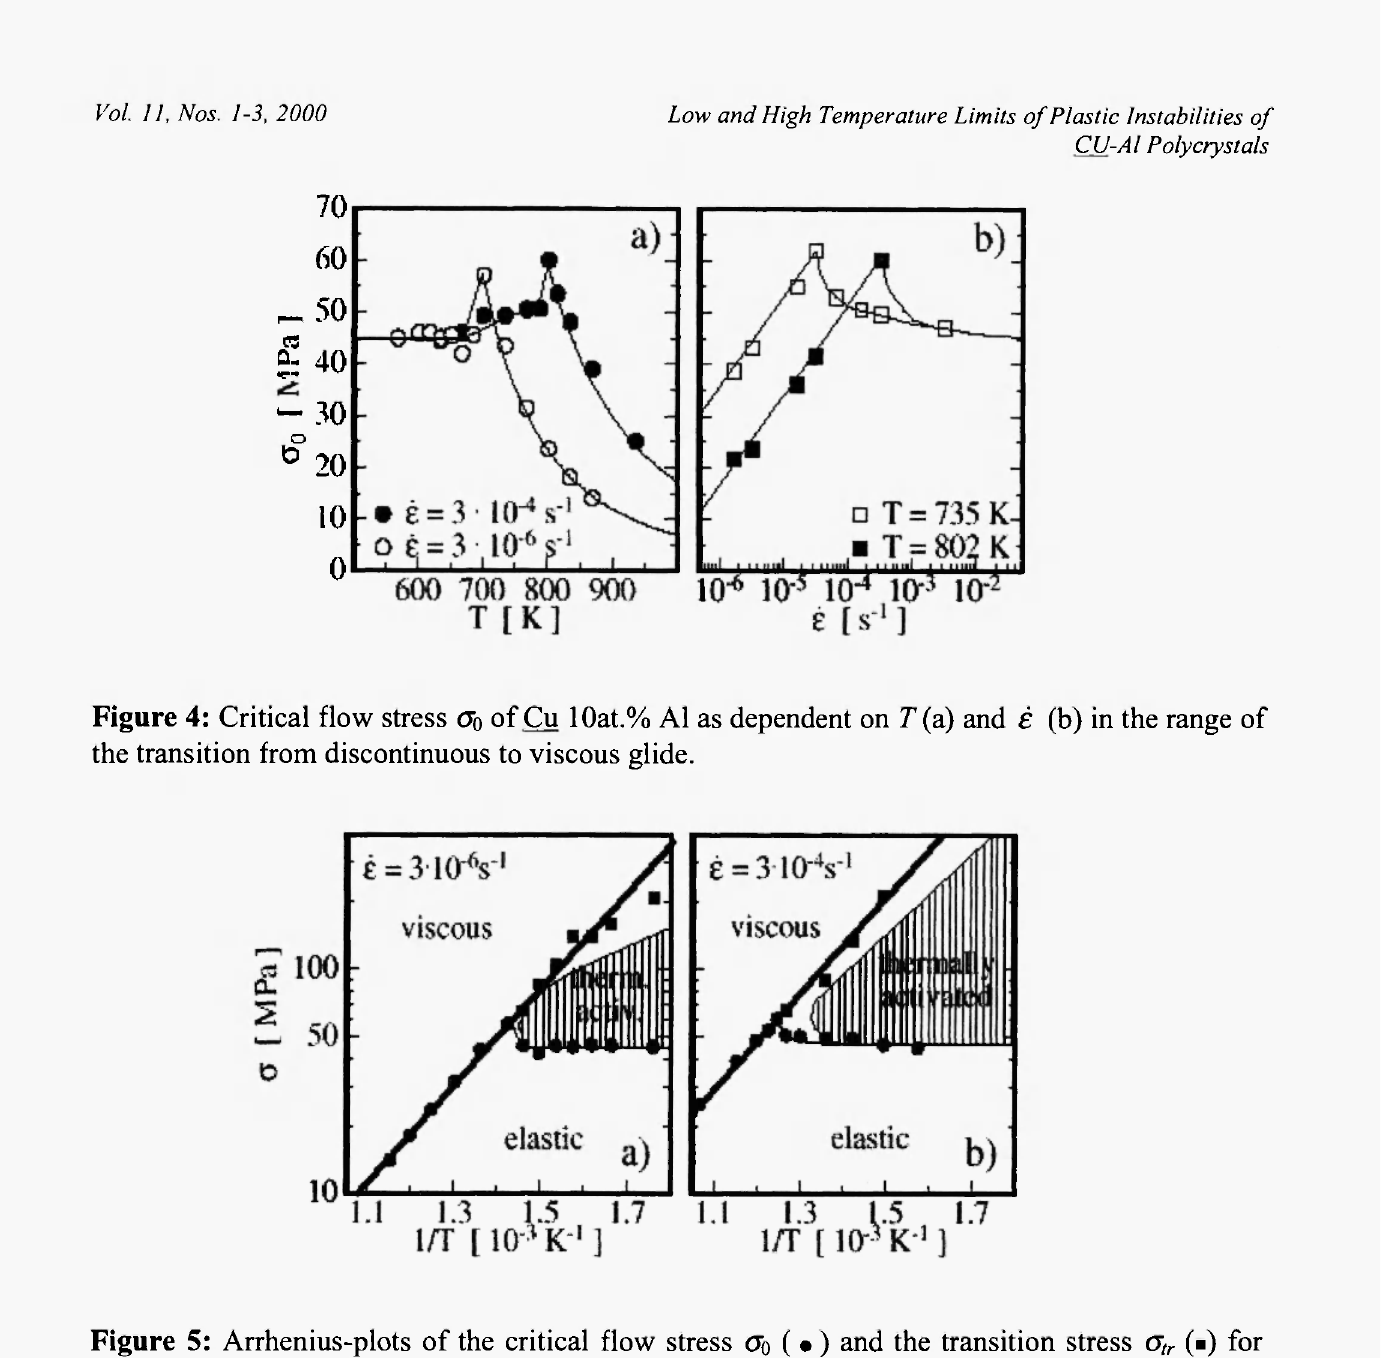
Figure 5: Arrhenius-plots of the critical flow stress σ (· ) and the transition stress o (•) for 0 tr two different strain rates. The boldly drawn lines separate deformation regions which are dominated by discontinuous dislocation motion (below) from those governed by viscous glide (above). The PLC effect (hatched areas) is only observed in the region where dislocations glide discontinuously. Some randomly distributed PLC serrations (cf. fig. 2) are observed up to the transition stress o tr